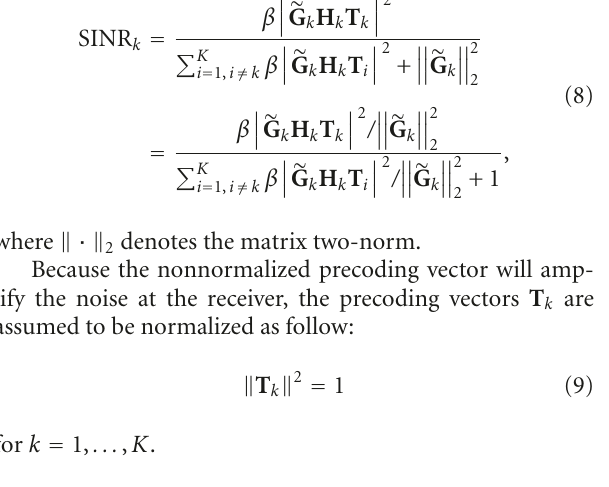
where H k is the MIMO channel matrix of user k . h i , j indicates the channel impulse response coupling the j th transmit antenna to the i th receive antenna. Its amplitude obeys independent and identically